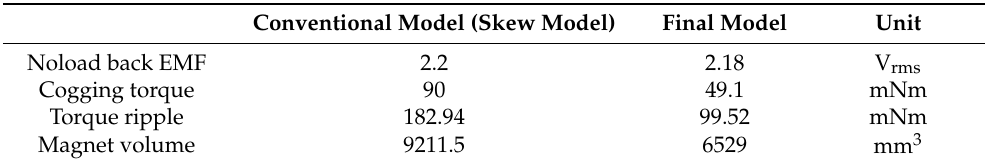
Table 2. Comparison of the existing and the final models.